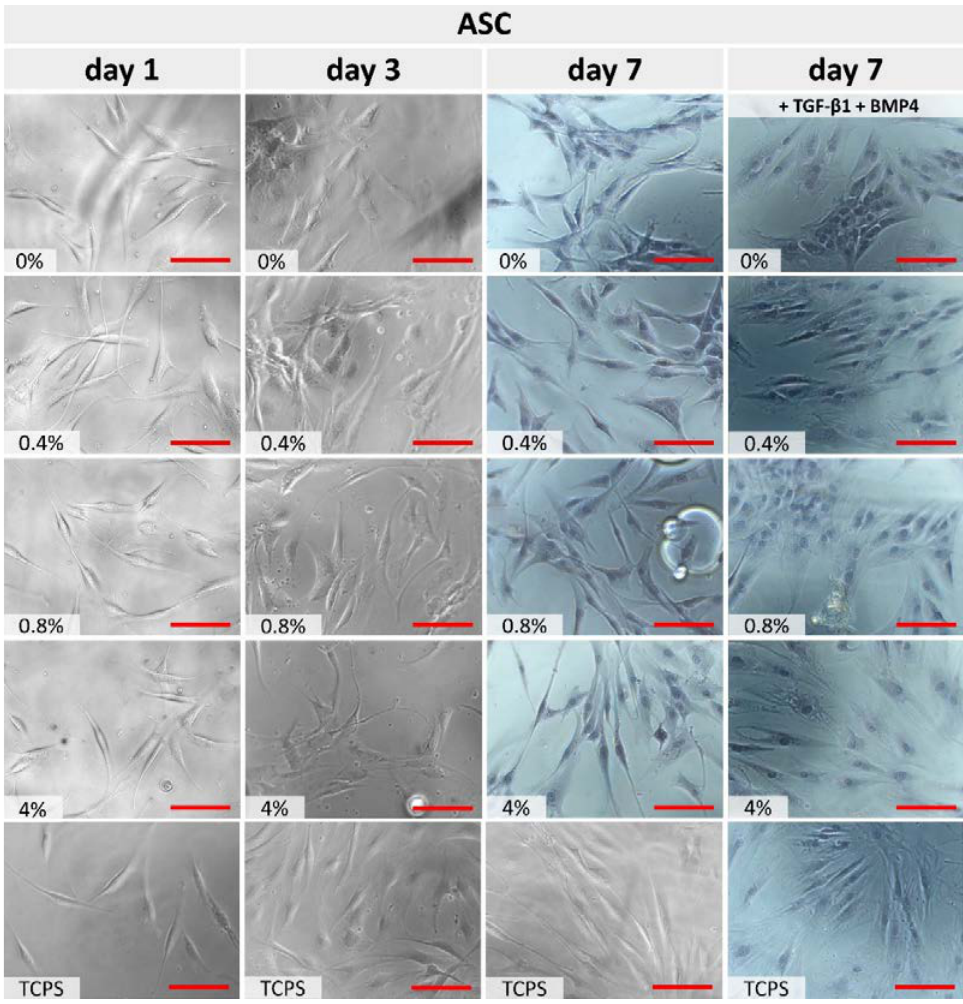
Figure 5. Optical microscopy of ASCs after 1, 3 and 7 days of culture on an unmodified cPOC surface (0 wt.% of GSH) and on cPOC modified with different concentrations of GSH (0.4, 0.8 and 4 wt.%). Cells cultured on TCPS served as the control. After day 7, except TCPS, the cells were stained with hematoxylin and eosin. Scale = 200 µm (red line).